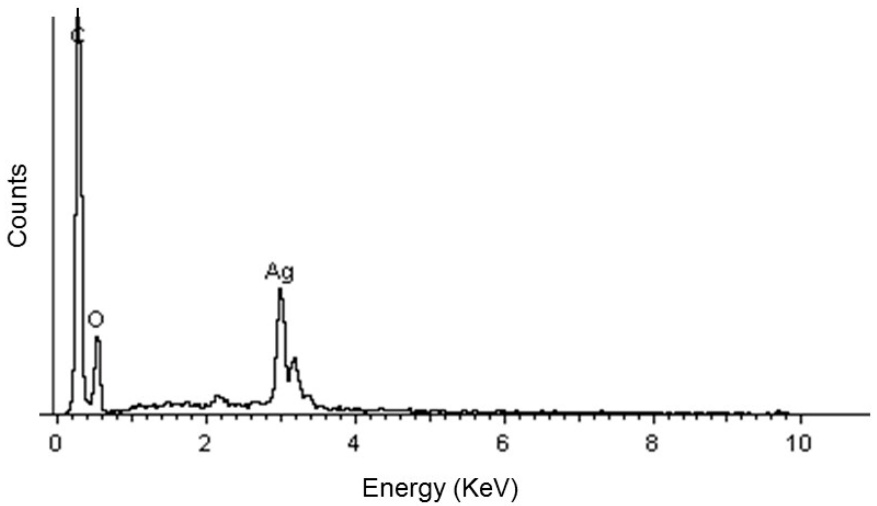
Figure 2. Scanning electron microscopy–energy dispersive X-ray spectrum of synthesized silver nanoparticles.